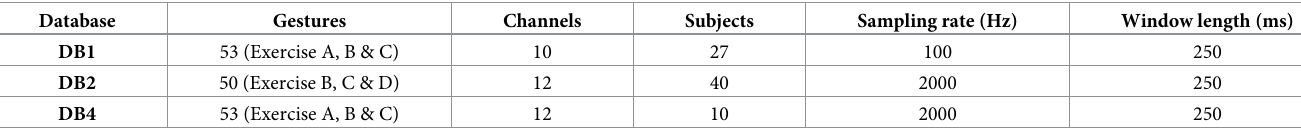
Table 2. Details of the three sEMG benchmark